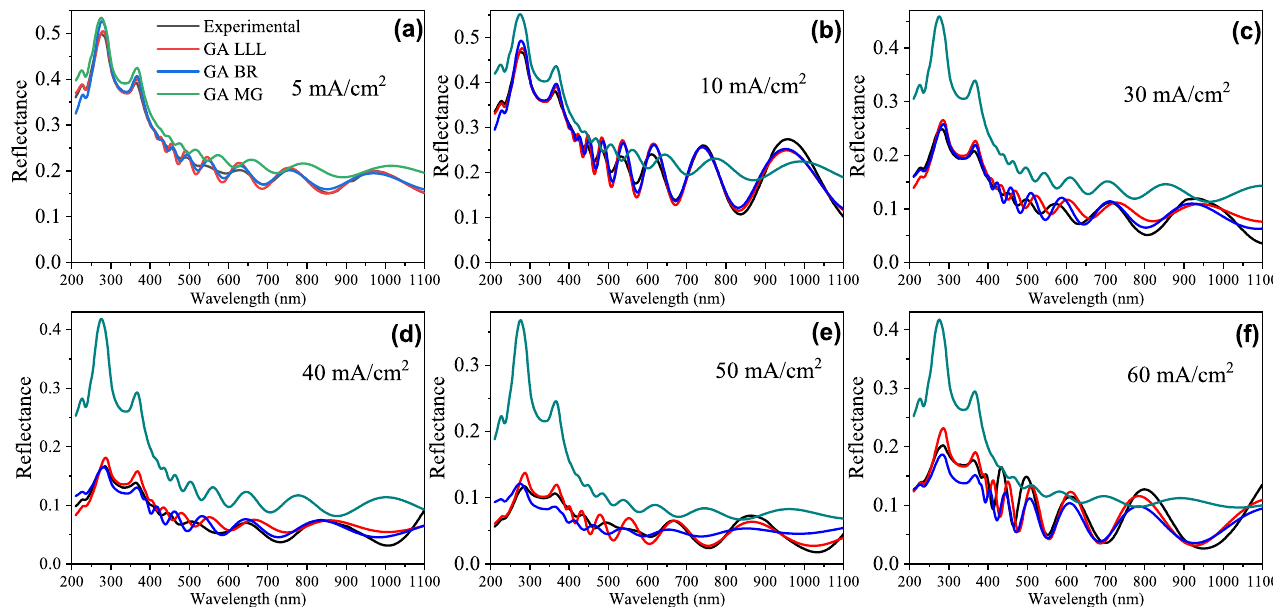
Figure 9. Near normal incidence reflectance (6 ◦ ) of representative samples as a function of wavelength. ( a ) 5 mA/cm 2 , ( b ) 10 mA/cm 2 , ( c ) 30 mA/cm 2 , ( d ) 40 mA/cm 2 , ( e ) 50 mA/cm 2 , and ( f ) 60 mA/cm 2 . The measured reflectance is compared to the theoretical reflectance calculated by Looyenga (LLL), Bruggeman (BR), and Maxwell Garnett EMA rules. The best fit value of porosity, thickness, absorption coefficient, and interface roughness are reported in Table